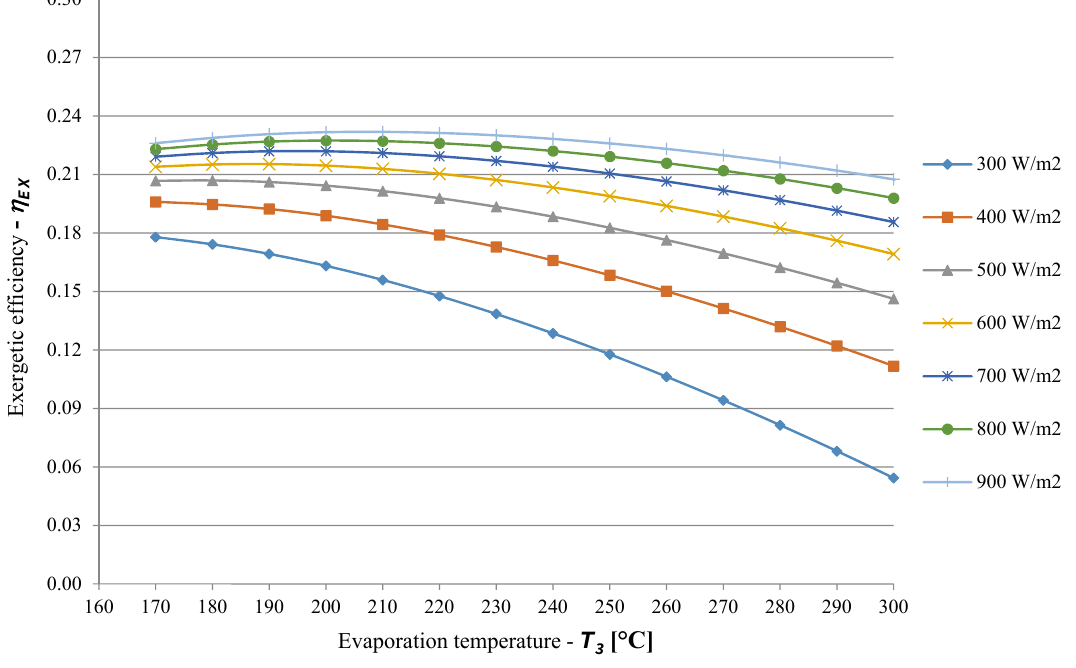
Figure 6. Exergetic efficiency versus vaporization temperature under growing solar radiation when the condensation pressure is fixed at 0.1 bar.